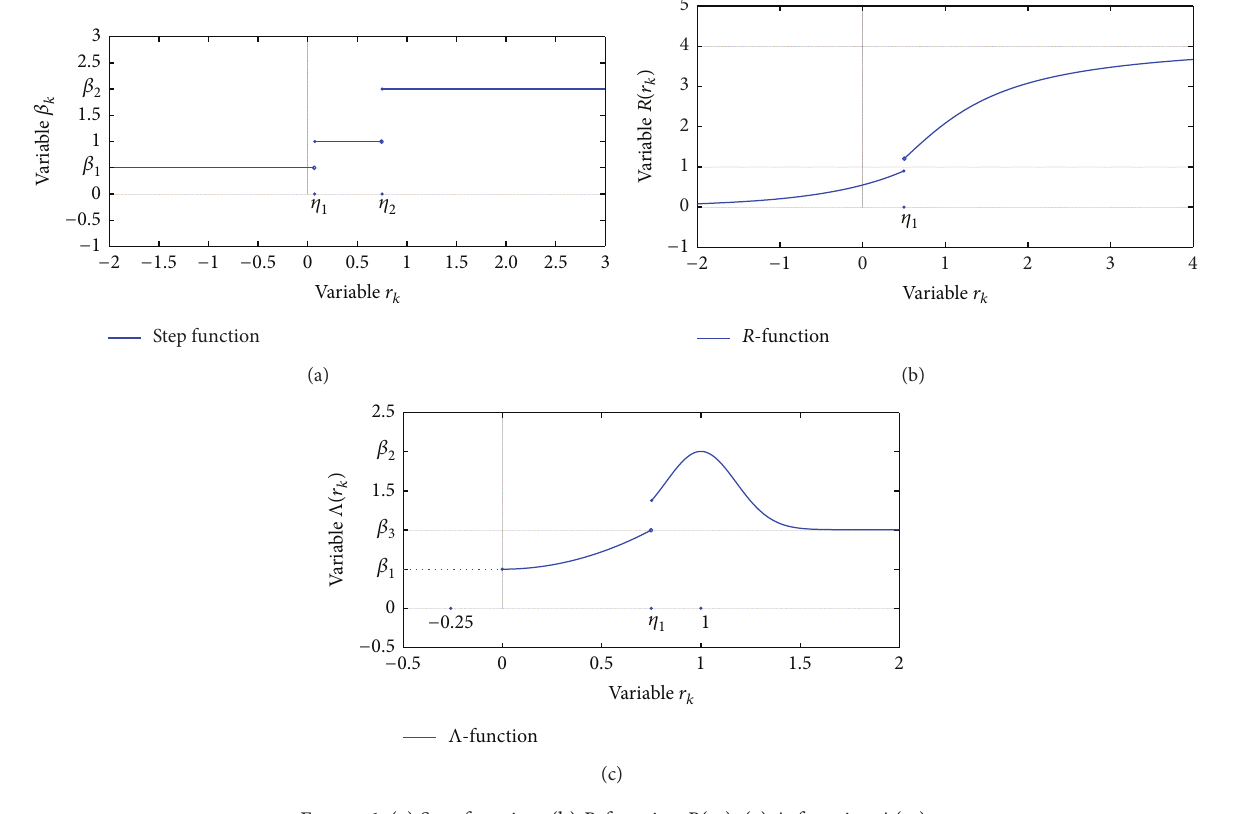
Figure 1: (a) Step function. (b) 𝑅 -function 𝑅(𝑟 𝑘 ) . (c) Λ -function Λ(𝑟 𝑘 ) .